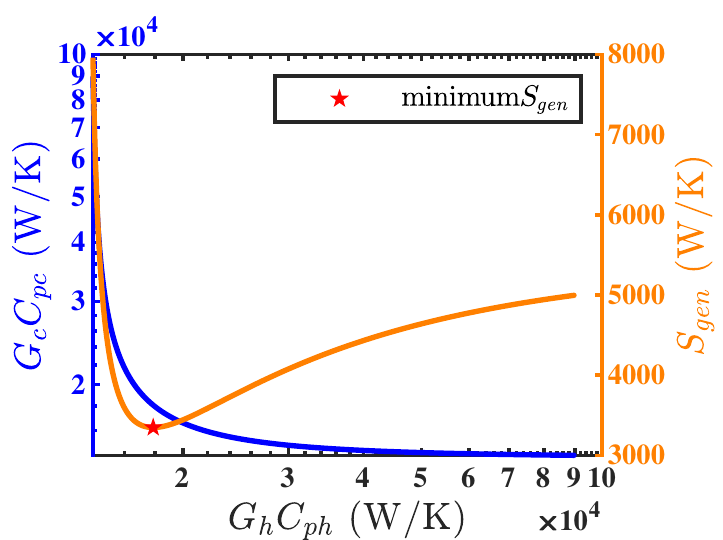
Figure 16. Different heat capacity rate pairs and corresponding total entropy generation.